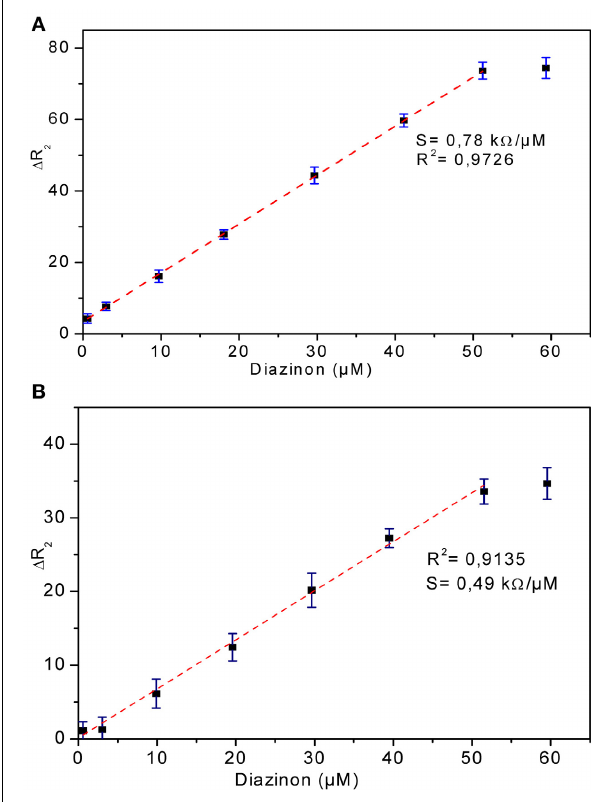
FIGURE 7 | Calibration curves of diazinon enzymatic biosensors (A) CRL, (B) PPL. Operational conditions: 20mM phosphate buffer, pH 5.2 at room temperature. Each point is the mean of three values.